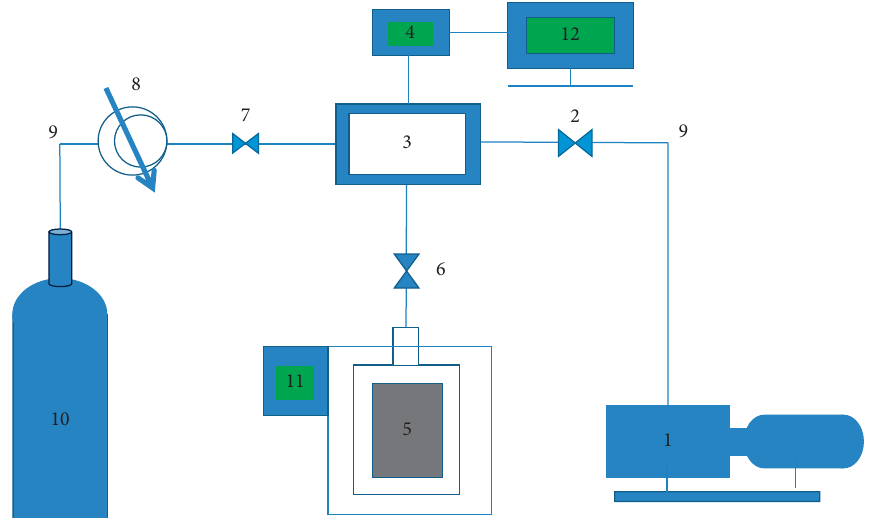
Figure 1: Experimental setup. Denoted elements are as follows: 1, vacuum pump; 2, 6, 7, electromagnetic valves; 3, difusion space; 4, pressure transducer and real-time data acquisition system (DAS); 5, coal sample container; 8, pressure regulating valve; 9, gas piping; 10, gas cylinder; 11, constant temperature water bath; 12, computer.